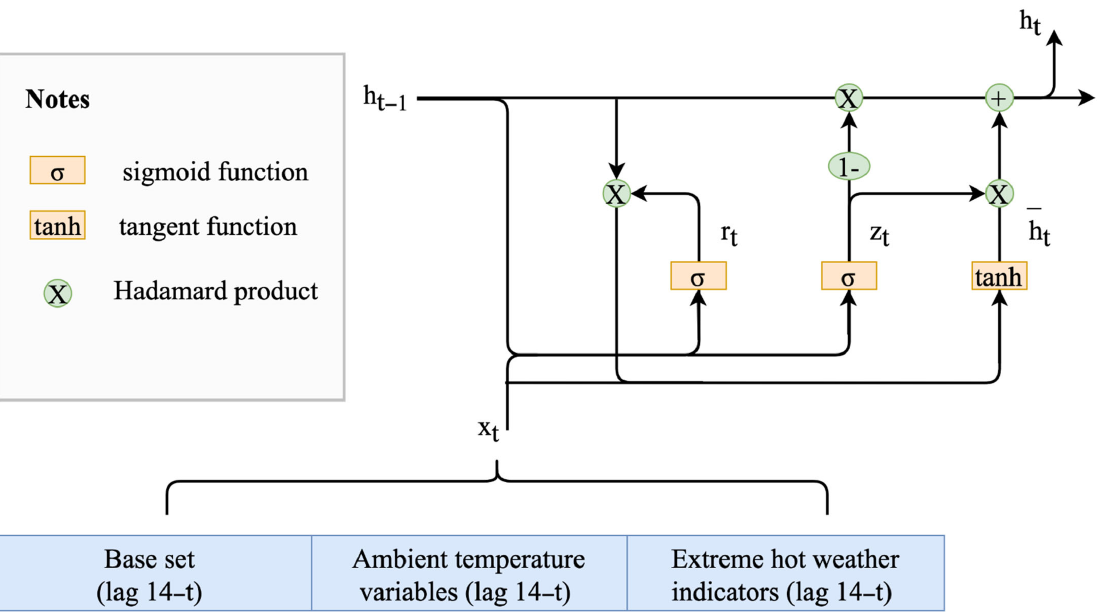
Figure 3. Proposed GRU structure.